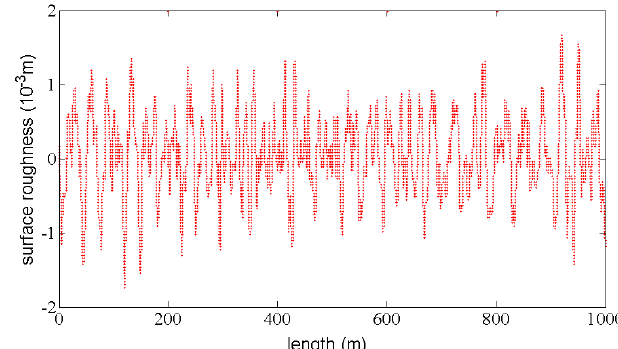
Figure 7. The surface roughness based on Japanese steel track irregularity.